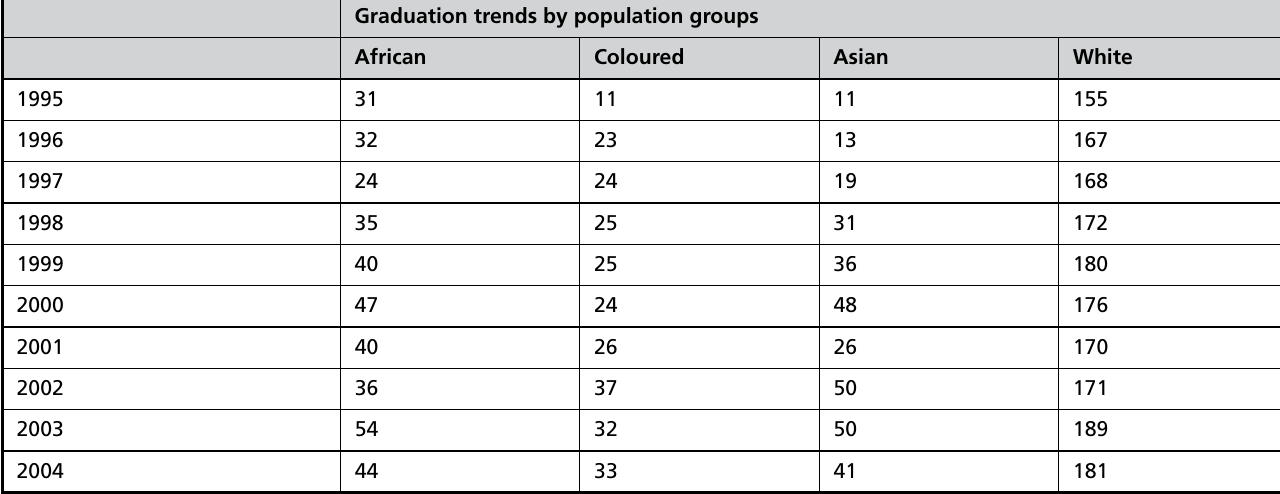
Table 1: Graduation trends in undergraduate physiotherapy education in South Africa (1995-2004) (South African Qualification Authority 2007) Graduation trends by population groups African Coloured